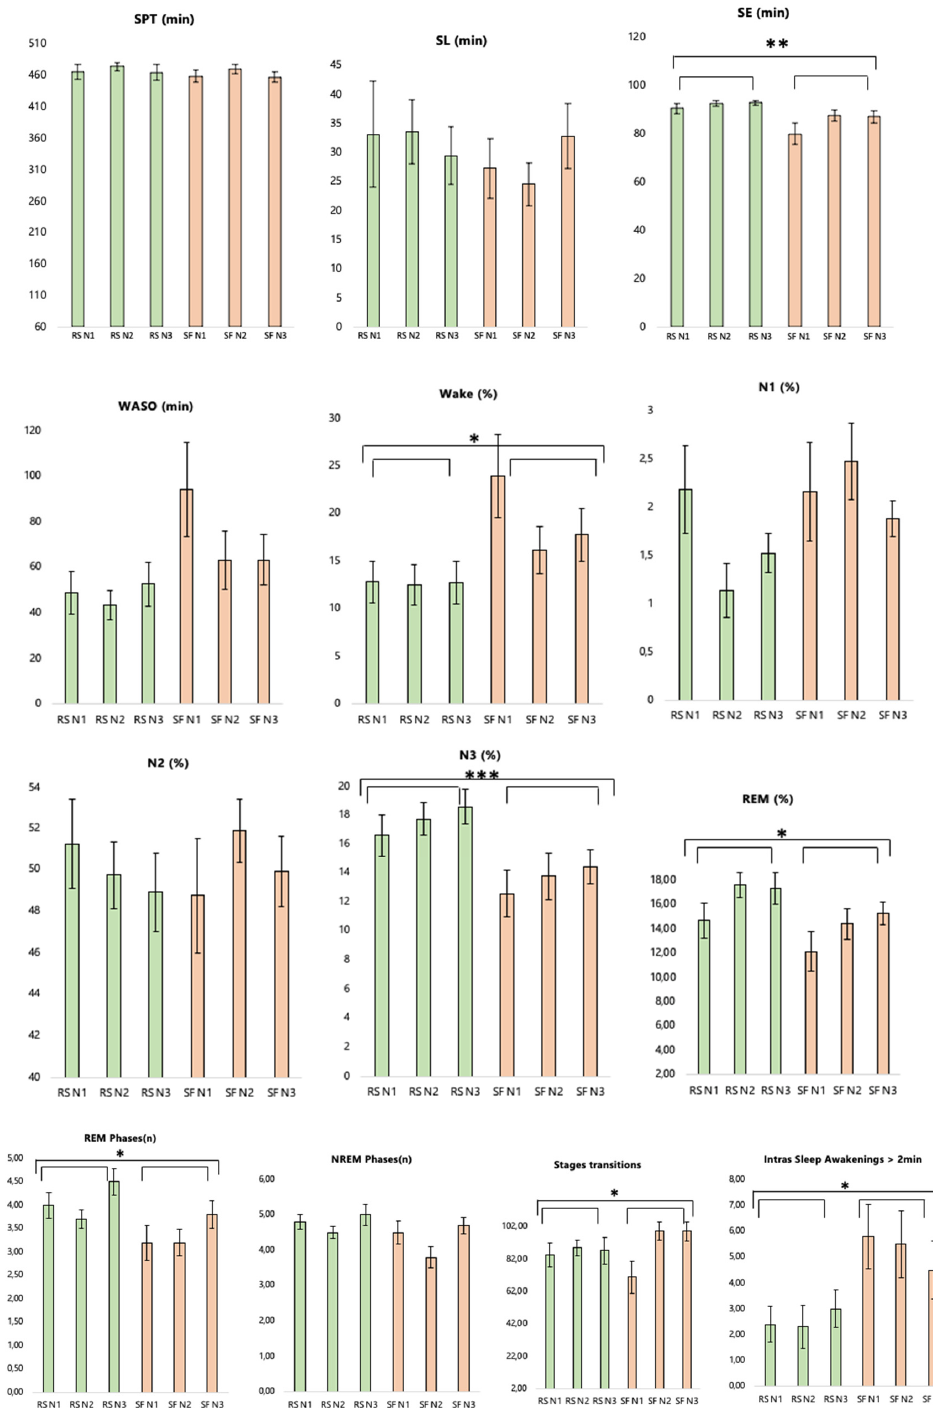
Figure 5. Polysomnographic parameters in control (RS) and fragmented (SF) sleep during the whole night. SPT = Sleep Period Time; SL = Sleep Latency; SE = Sleep Efficiency. WASO = Wake After SleepOnset; Wake (%) = percentage of wake; N1 (%) = percentage of N1; N2 (%) = percentage of N2; N3 (%) = percentage of N3; REM (%) = percentage of REM; REM Phases = number of REM phases; NREM Phases = number of NREM phases; stage transitions = number of stage transitions; Intra- Sleep Awakenings > 2 min = number of wake periods with a minimal duration of 2 min; * p < 0.05, ** p < 0.01, *** p < 0.001. Error bars represent standard